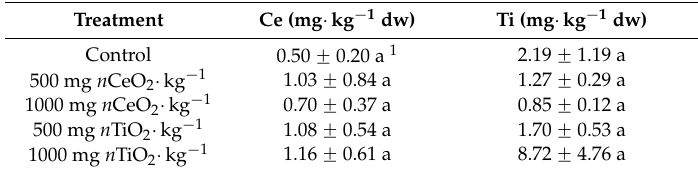
Table 5. Cerium and titanium concentration in barley kernels at ripening from main shoot grown in soil treated with none (Control), 500 mg n CeO 2 ¨ kg ´ 1 , 1000 mg n CeO 2 ¨ kg ´ 1 , 500 mg n TiO 2 ¨ kg ´ 1 and 1000 mg n TiO 2 ¨ kg ´ 1